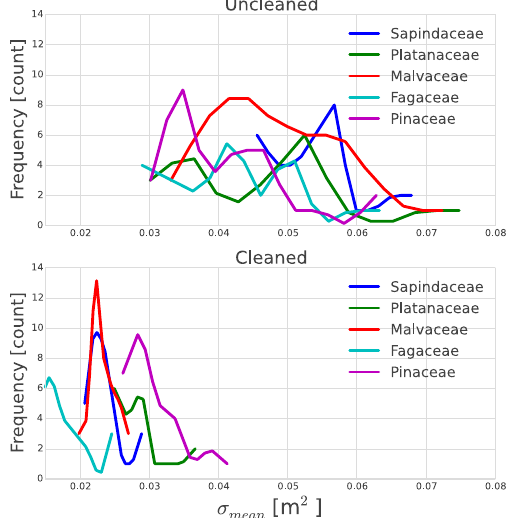
Figure 4. Histogram of mean backscatter cross-section ( σ mean ) of uncleaned and cleaned data, coloured by tree